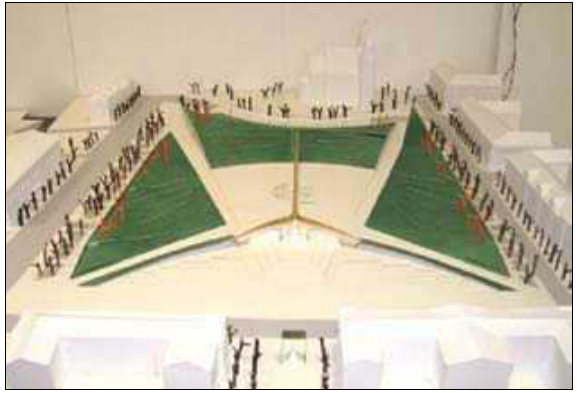
6 pav. Lukiškių aikštės sutvarkymo konkursinis projektas. anuškevičiaus PĮ „archijonas“ (U. krušinskienė, r. Puzinas, V. Izokaitis) su skulpt. D. Matulaite, 2009 Fig. 6. Lukiškės Square reconstruction competition. Project by anuškevičius PĮ “archijonas” (U. krušinskienė, r. Puzinas, V. Izokaitis) with participation of sculptor. D. Matulaite, 2009